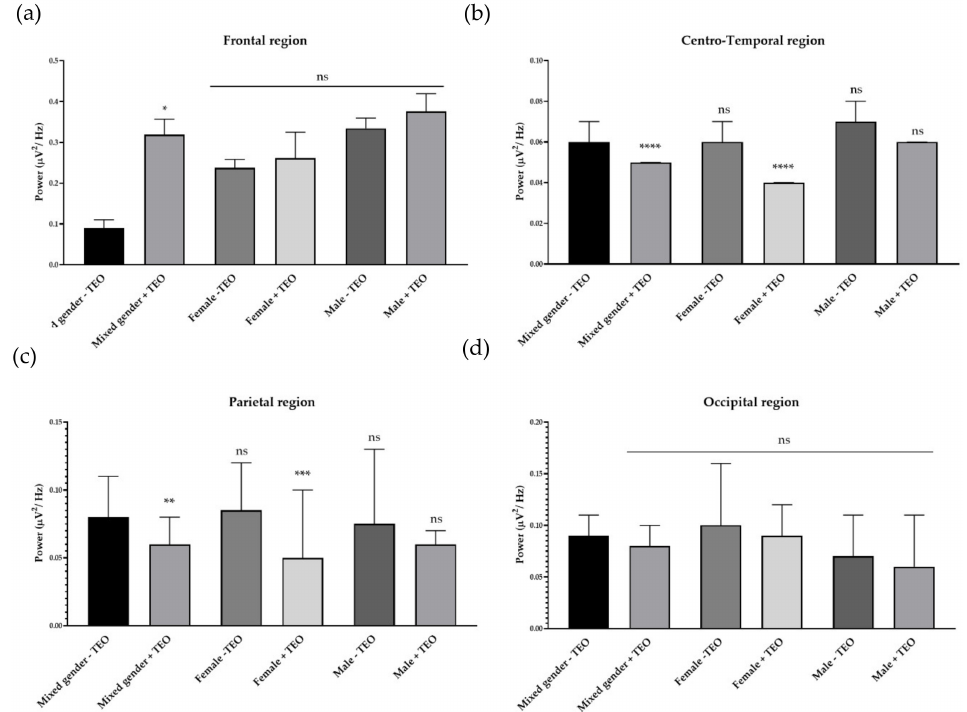
Figure 3. E ff ects of tangerine essential oil on slow alpha (9 Hz): ( a ) Frontal region; ( b ) Centro-Temporal region; ( c ) Parietal region; ( d ) Occipital region. p value: ns ≥ 0.05, * < 0.05, ** < 0.01, *** < 0.001, **** < 0.0001.